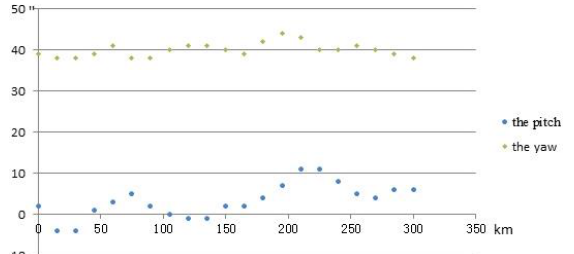
Figure 2. Distribution of low-frequency errors in the direction of pitch and yaw